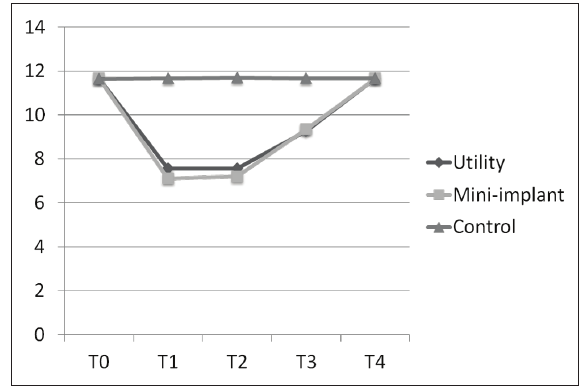
Figure 1. The changes in the maxillary incisor PBF over time in the study groups, compared to the relatively constant PBF in the control group.